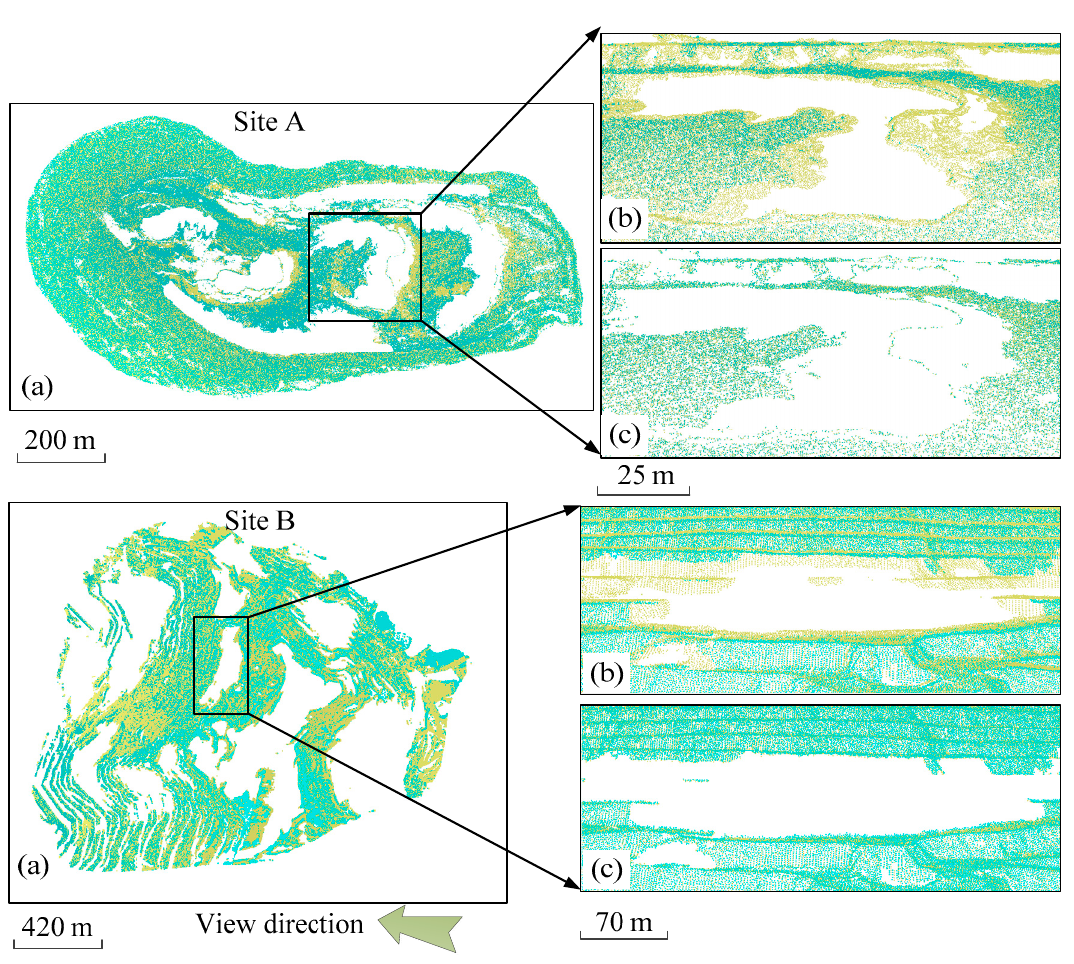
Figure 10. Registration of terrain ‐ invariant regions over both sites with the proposed method. ( a ) Overview results at the first iteration, ( b ) and ( c ) local close ‐ up view of the registration yielded by the proposed method at the first and last iterations, respectively.